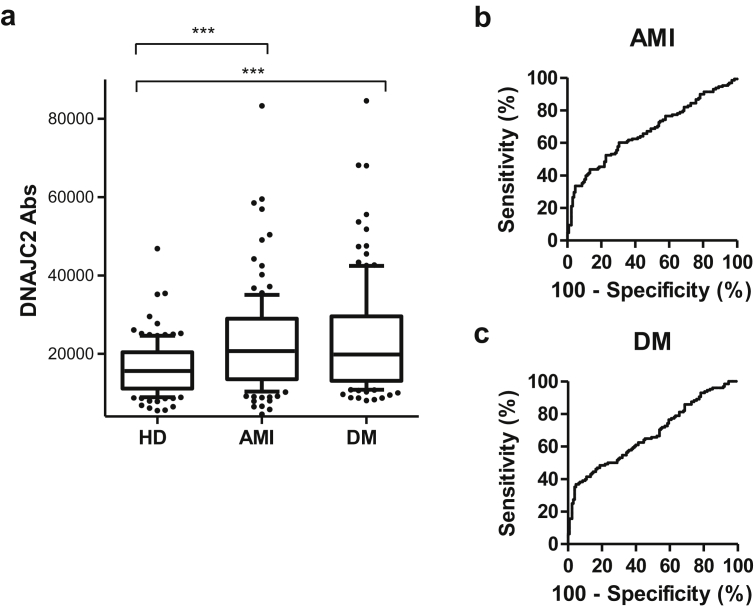
Association between DNAJC2-Ab levels and other atherosclerotic diseases including AMI and DM. (a) Serum DNAJC2-Ab levels of the HDs and the patients with AMI or DM determined by AlphaLISA are shown as box-whisker plots, as described in the legend of Figure 2. The mean ages (±standard deviation) of the HDs and the patients with AMI and DM were 58.29 ± 5.63, 58.28 ± 8.5, and 58.37 ± 9.11 years, respectively. Results of the ROC analysis of DNAJC2-Abs to detect AMI (b), and DM (c) are also shown. ∗∗∗p < 0.001 by the Mann–Whitney U test with type I error adjustment using the Bonferroni procedure.